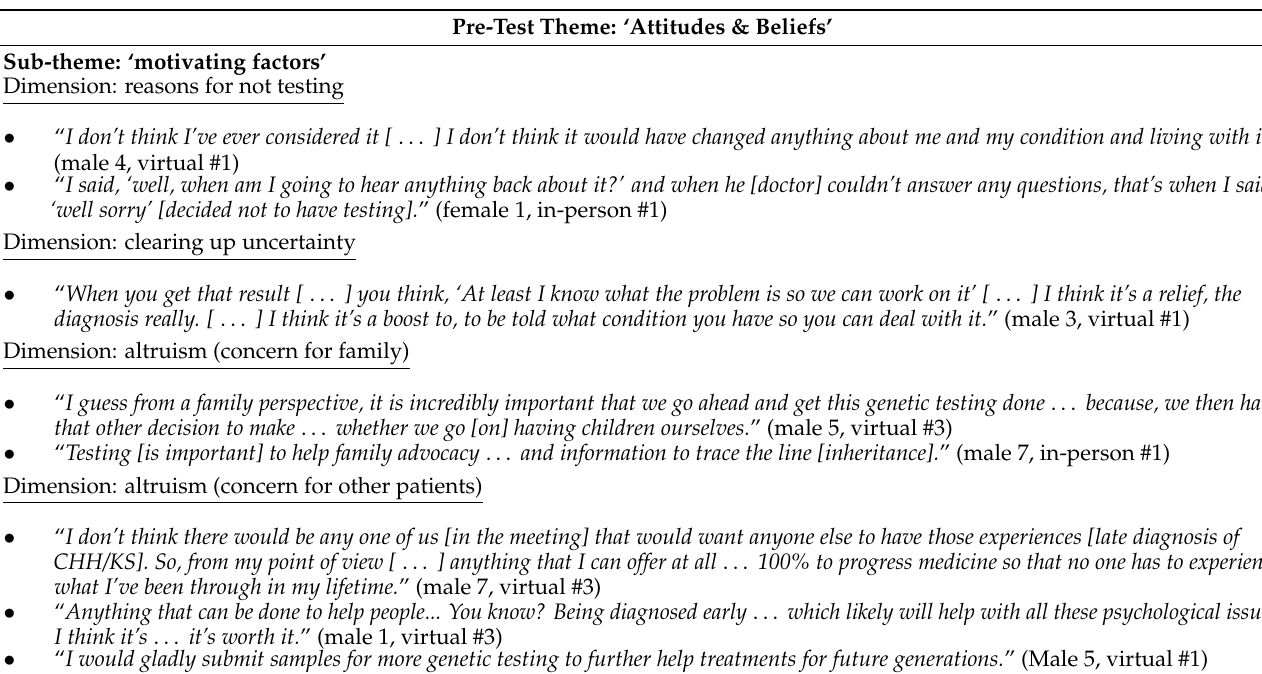
Table 2. Representative quotes relating to pre-test experiences: ‘attitudes &